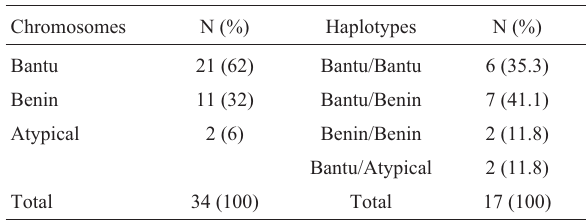
Table 2 - Frequency of (cid:2) S chromosomes and genotypes in 17 Hb SS indi-